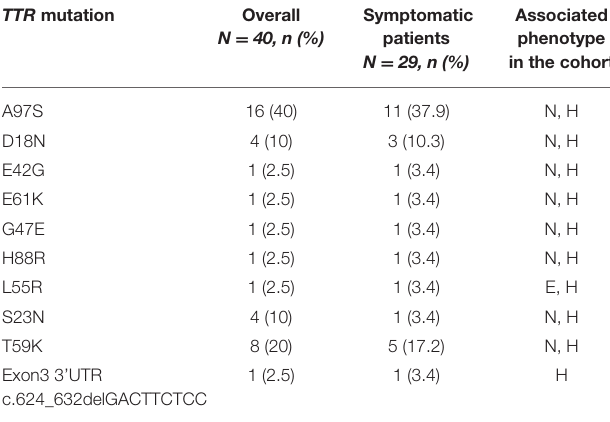
TABLE 3 | Genotype distribution in probands and family members.